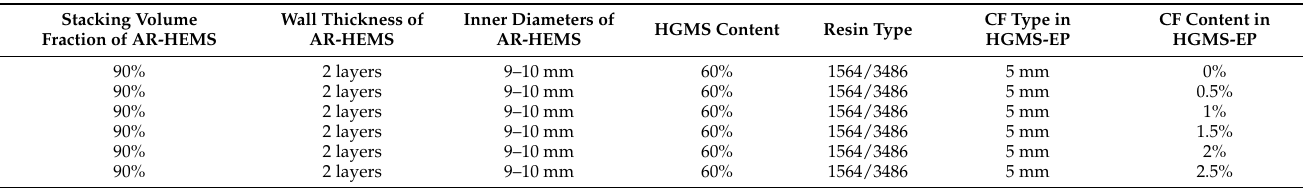
Table 4. Six samples of ESF reinforced by CF with different contents.